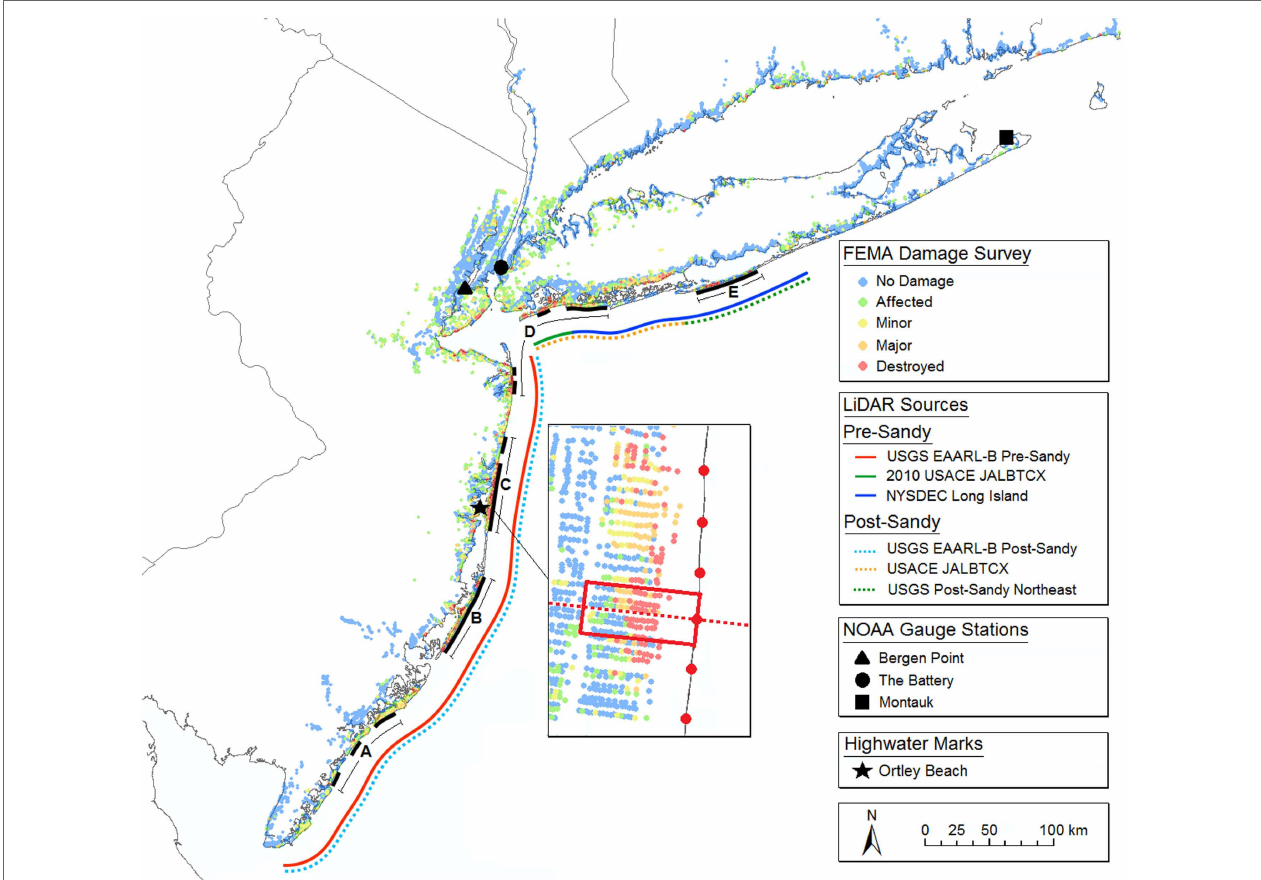
FIGURE 1 | Federal Emergency Management Agency (FEMA) aerial damage survey of New York and New Jersey. Portions (A–E) of coastline considered in the study are outlined in black. The subfigure shows the results of the FEMA survey for Ortley Beach, NJ and an example of the 200m (cid:2) 300m discretization and one-dimensional transect used in the study. (Red circles in the subfigure represent the center points of the 200m discretization of the coast.) Black triangle, circle, and square markers show the location of NOAA gages at Bergen Point, the Battery, and Montauk, NY. The black star marker shows the location of surveyed highwater marks in Ortley Beach,